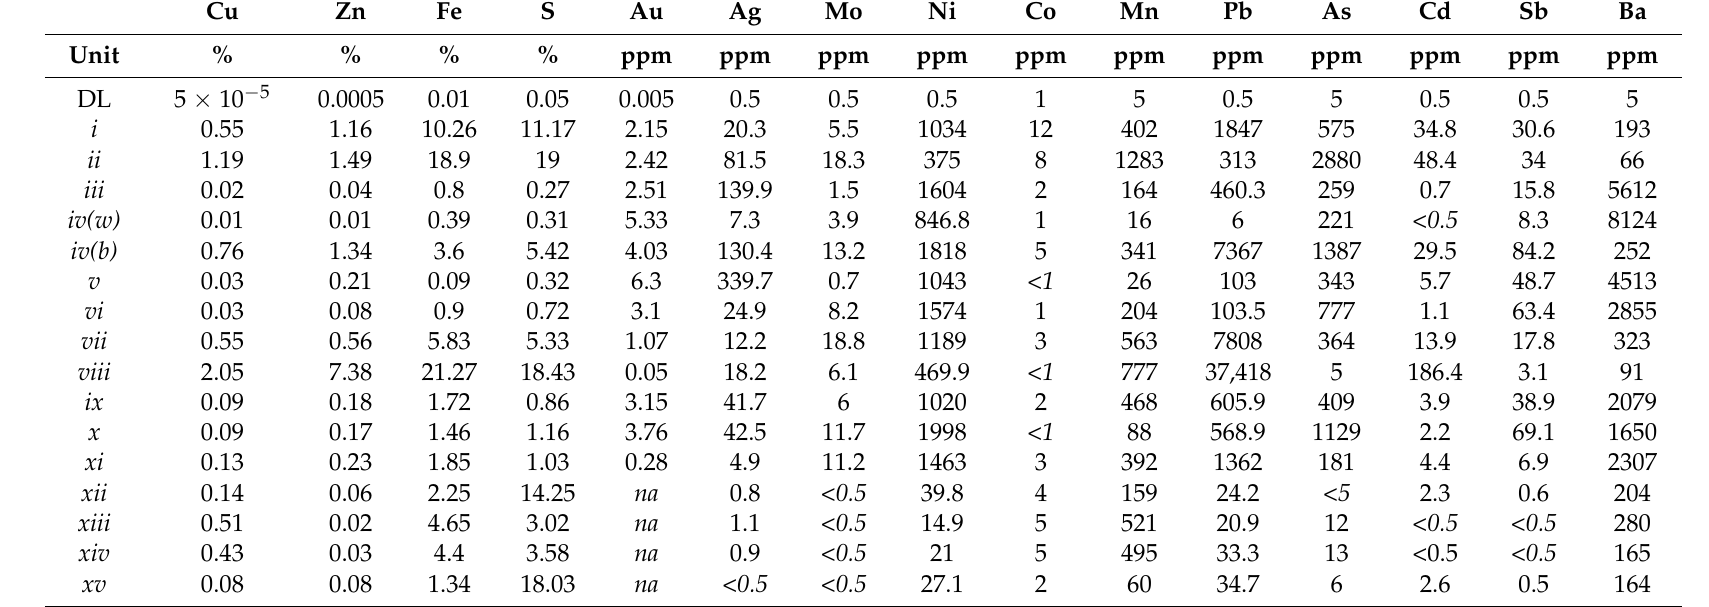
Table 5. Selected whole-rock geochemistry for the 15 selected vent samples. DL is the detection limit. na is not